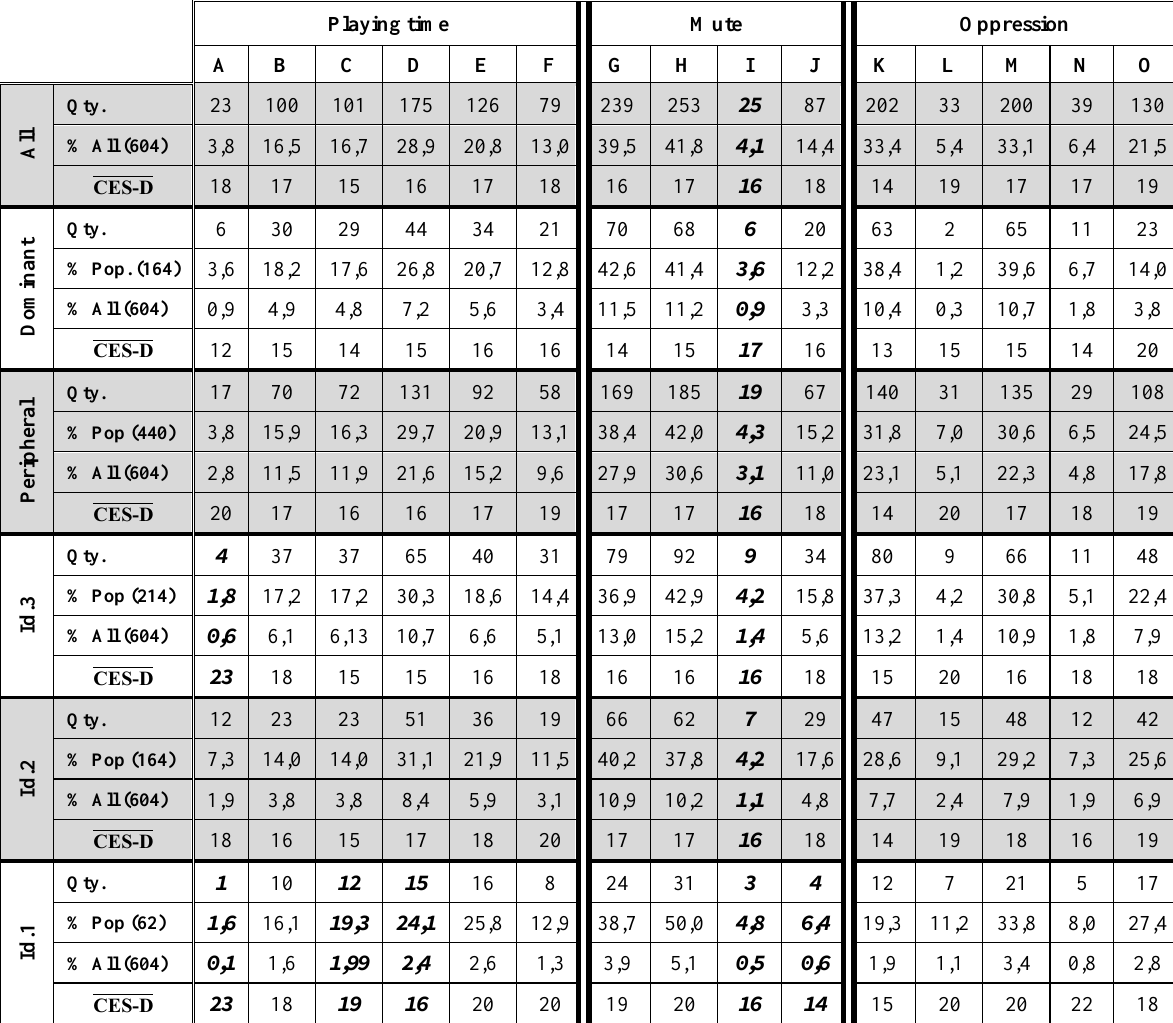
Table 7 : Quantitative data related to play time, muting and oppression, by identities Playing